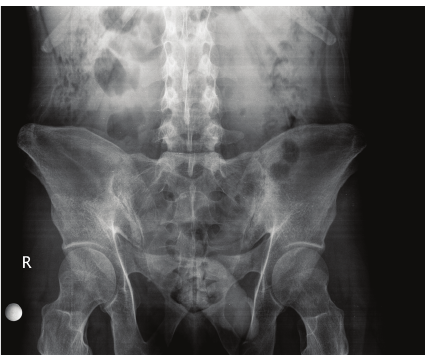
Figure 1: Direct radiography of the sacroiliac joints showing bilateral